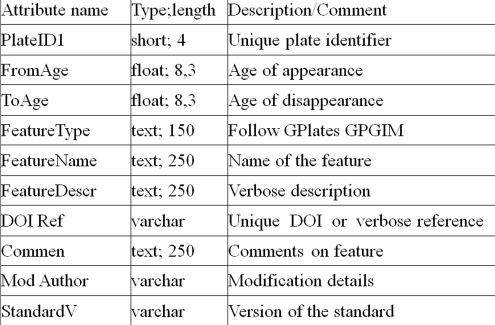
Fig. 32. Basic shapefile standard attribute names, types and descrip- tion, which allow direct interoperability between GIS shapefiles and